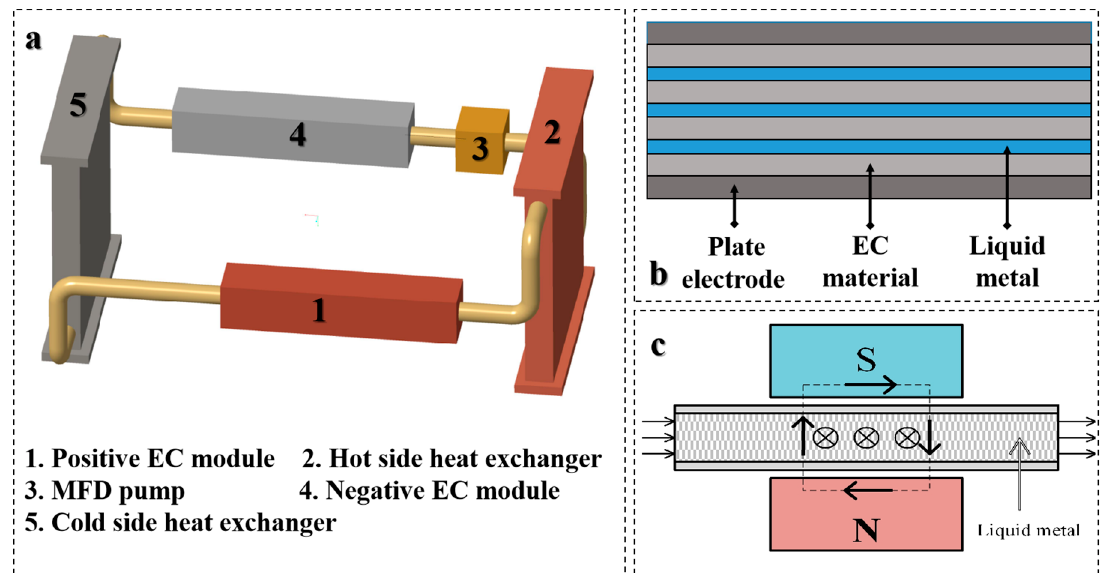
Figure 2. ( a ) System design of EC heat pump; ( b ) detailed two-dimensional structure of EC heat pump; and ( c ) detailed structure of MFD pump.